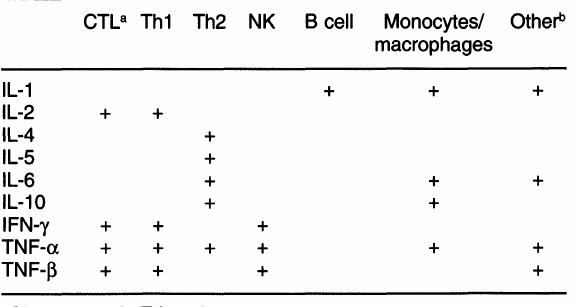
Table 1. Cell sources of cytokines relevant in